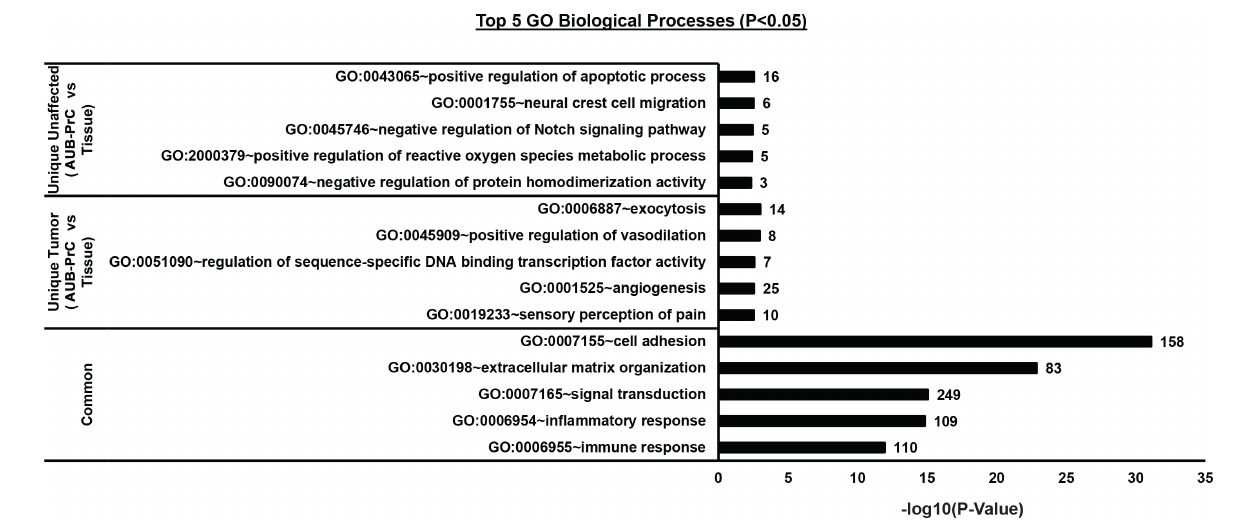
FIGURE 5 | Biological processes Gene Ontology (GO) analysis of the DEGs lists between AUB-PrC cells vs. tissue in unaffected and tumor samples. [Unique genes in unaffected AUB-PrC cells vs. tissue (543 DEGs), unique genes in tumor AUB-PrC cells vs. tissue (1410 DEGs), and common genes between unaffected and tumor (2840 DEGs)] were isolated based on the Venn diagram and further analyzed via DAVID platform (Huang Da et al., 2009) to identify the top 5 GO biological processes.